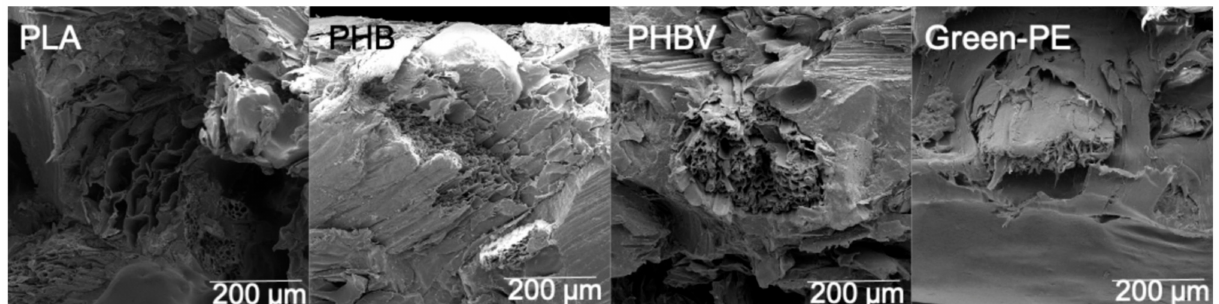
Figure 7. SEM micrographs of biocomposites at higher